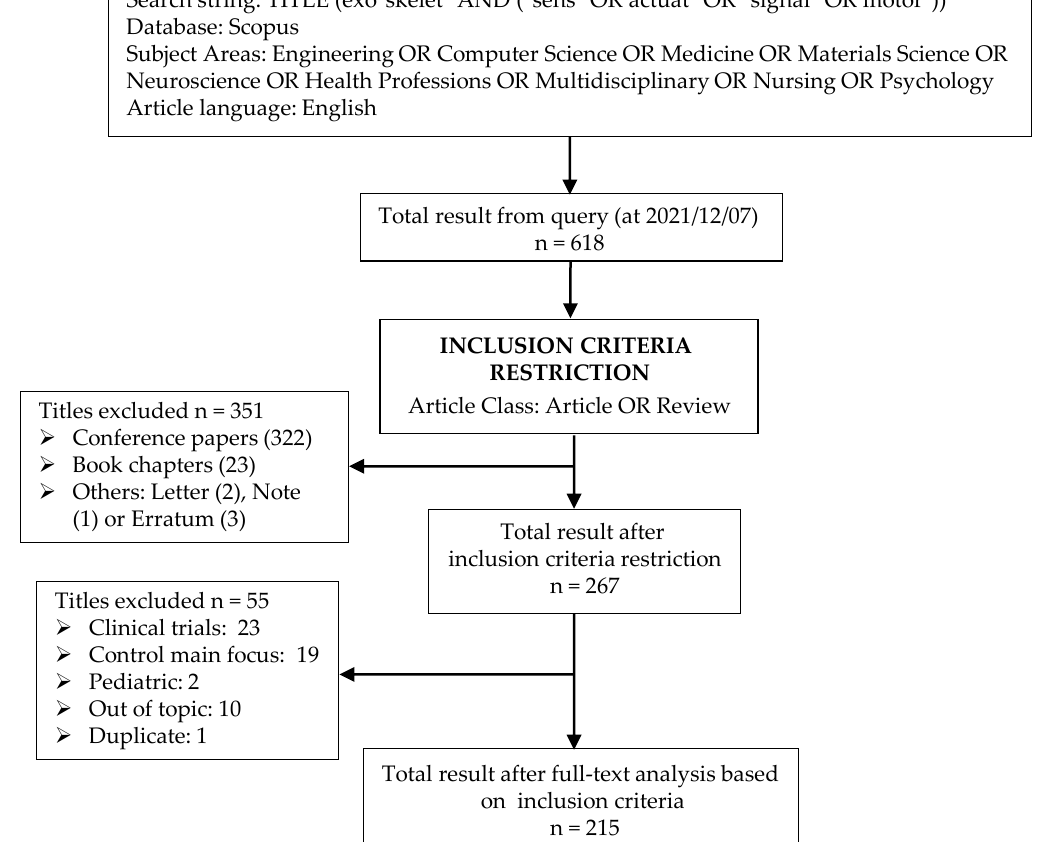
Figure 5. Flow chart mapping the selection process with the number of records identified, included and excluded and the reasons for